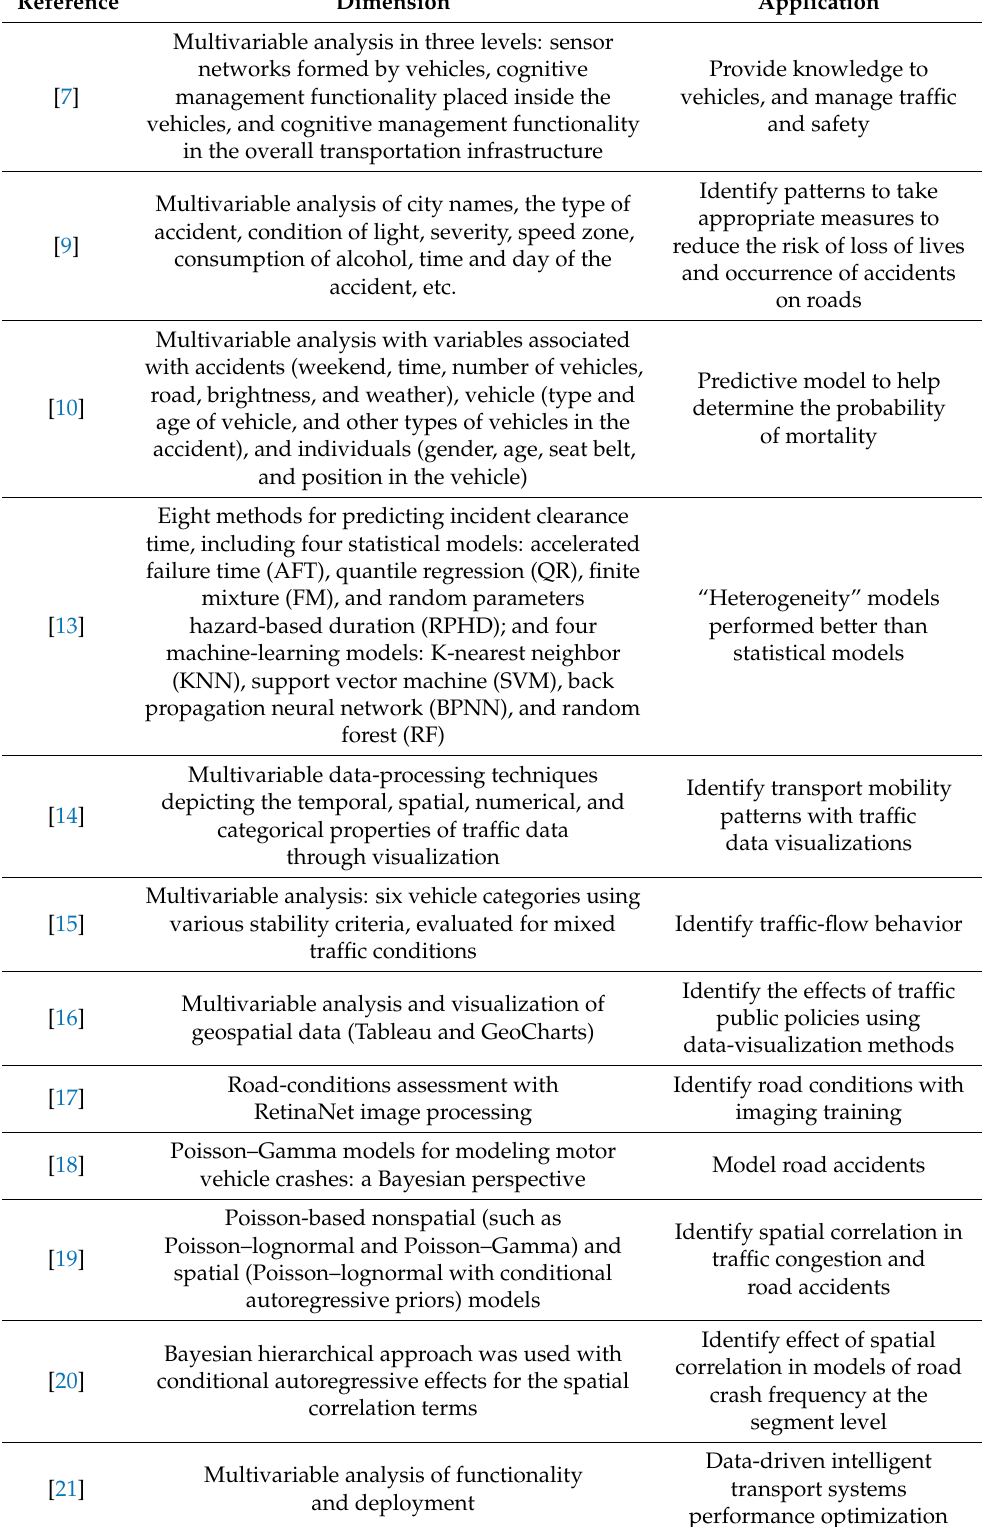
Table 1. Literature review